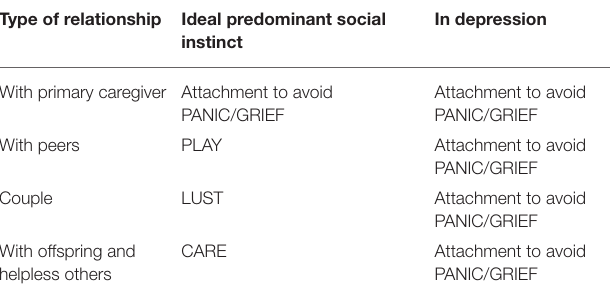
TABLE 1 | Comparison between the ideal predominant social instincts and in depression for the different types of relationships. Type of relationship Ideal predominant social In instinct